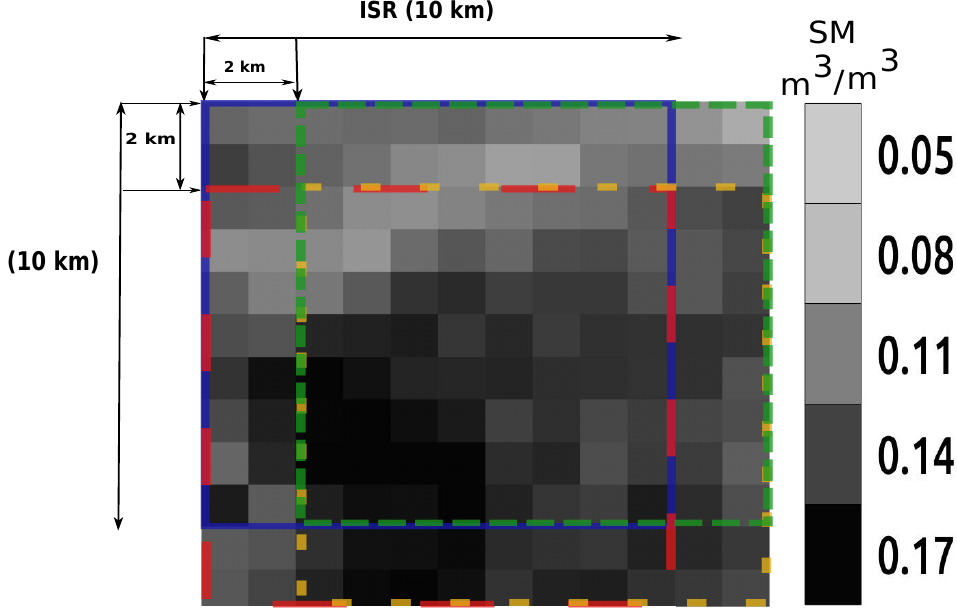
Figure 6. Illustration of the moving average window algorithm applied to the 1 km resolution DISPATCH Lin SM with a shift of ISR (set to 10 km in this case) grids in both directions (east-west and north-south) with a constant spacing of 2 km between ISR